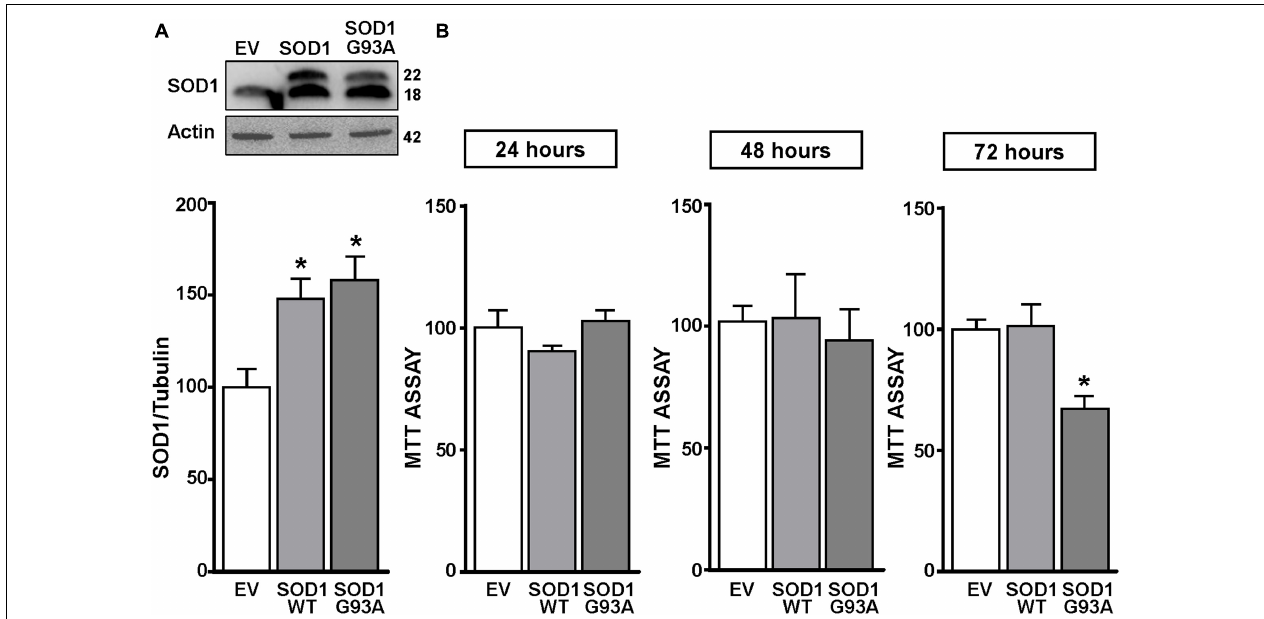
FIGURE 1 | SOD1 protein levels and cell viability in motor neuron like NSC34 cells transiently transfected with the empty vector, SOD1-WT and SOD1-G93A constructs. (A) Western Blot of SOD1 in NSC34 transiently transfected with the followed vectors: (1) empty vector (EV), (2) wild type human SOD1 (SOD1-WT) and (3) human SOD1 containing the G93A mutation (SOD1-G93A). Graphs show quantification of ratio of SOD1 and Actin. Bars represent mean ± SD ( n = 3); * p ≤ 0.05 versus EV. (B) Effects of EV, SOD1-WT and SOD1-G93A vectors on cell survival, measured by MTT assay after 24, 48, and 72 h transfection. Bars represent mean ± SD ( n = 3); * p ≤ 0.05 versus EV and